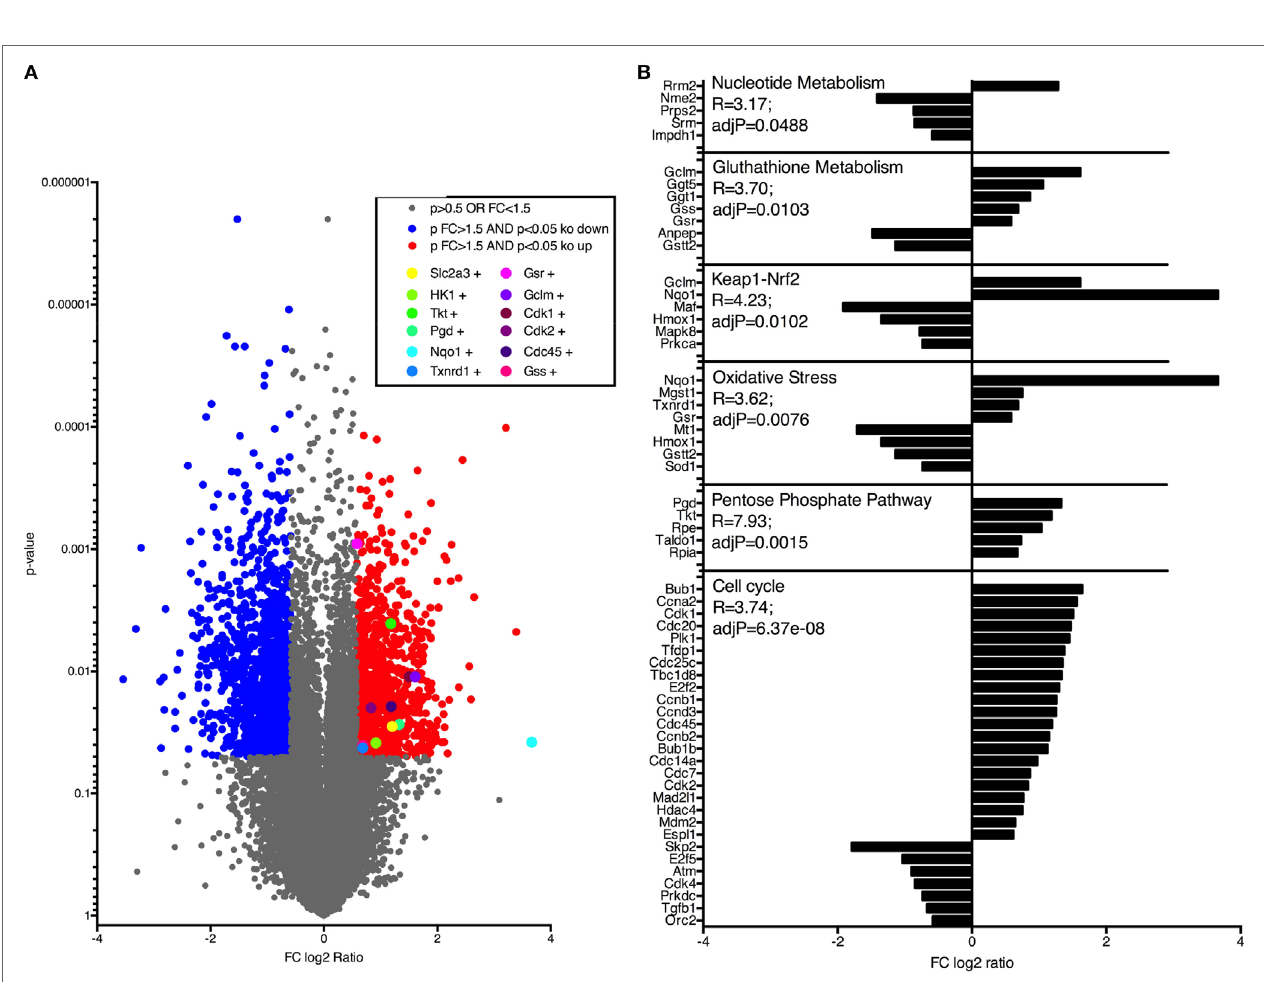
FigUre 2 | CD11b + Gr-1 + cells from VAV cre Keap fl/fl reveal characteristics of myeloid-derived suppressor cells (MDSCs). (a) Representative arginase-histogram showing overlays of pre-gated CD11b + Gr-1 + cells in spleens from Keap fl/fl (black), VAV cre Keap fl/fl mice (gray), and an appropriate isotype control. (B) Flow cytometric analysis of Nos2 expression in pre-gated CD11b + Gr-1 + cells from spleens. Representative contour plots showing isotype control (left) and Nos2 expression from Keap fl/fl (middle) and VAV cre Keap fl/fl mice (right). (c) Statistical analysis of Nos2-positive cells in pre-gated CD11b + Gr-1 + Keap fl/fl ( n = 3) and VAV cre Keap fl/fl ( n = 3) mice, two-tailed unpaired t -test. Bars indicate mean and error bars SEM of three mice per group. (D) Statistical analysis of ROS + cells in pre-gated CD11b + Gr-1 + from Keap fl/fl ( n = 6) and VAV cre Keap fl/fl ( n = 8) mice, two-tailed unpaired t -test. (e) Representative contour plots showing reactive oxygen species (ROS) positive cells pre-gated on CD11b + Gr-1 + cells cultured at 37°C for 1 h. (F) N-fold mRNA expression of cytokines in MACS isolated Keap fl/fl and VAV cre Keap fl/fl CD11b + Gr-1 + ( n = 4) cells analyzed by RT-qPCR. Bars indicate mean and error bars SEM, two-tailed one sample test. (g–J) OT-II CD4 + T cells were labeled with the cell proliferation dye eFluor 660 and cultured alone, in the presence of DCs, or in the presence of OVA-fed DCs, or co-cultured with OVA-fed DCs or different ratios of Gr1 + CD11b + cells from VAV cre Keap fl/fl mice. (g) After 3 days of culture, T cell proliferation was measured by loss of eFluor fluorescence on flow cytometry. (h) Statistical analysis of cell proliferation, as assessed by percentages of proliferated cells. Bars indicate the mean of three independent experiments and error bars SEM (two-tailed, paired t -test). (i) Statistical analysis of absolute CD4 + cells after 3 days of culture. (J) Statistical analysis of dead CD4 + T cells, as determined by incorporation of 7-AAD, two-tailed unpaired t -test. Bars indicate the mean of three independently performed experiments and error bars SEM. (K) CD4 + CD25 − transfer colitis: body weight as a percent of starting weight of control mice ( n = 4, blue symbols), MDSC recipient control mice ( n = 2, black), CD4 + CD25 − recipient mice ( n = 8, red), and CD4 + CD25 − + MDSCs recipient mice (gray, n = 7) over the course of 5.5 weeks. (l) Statistical analysis of frequencies of CD4 + T cells in spleen and mesenterial lymph nodes